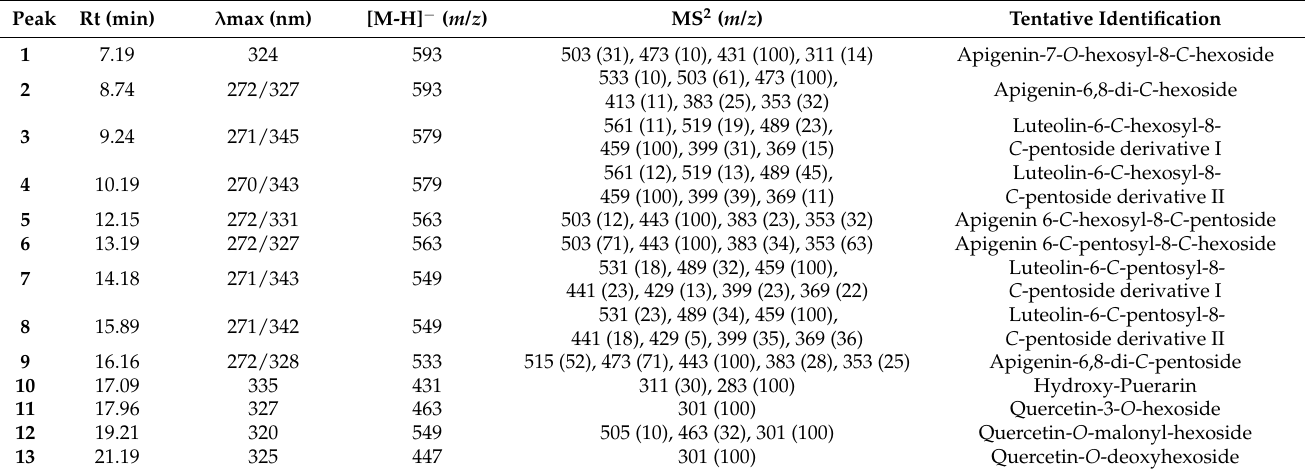
Table 3. Retention time (Rt), wavelengths of maximum absorption ( λ max), mass spectral data, and tentative identification of the phenolic compounds present in the hydroethanolic and aqueous extracts of C. erecta